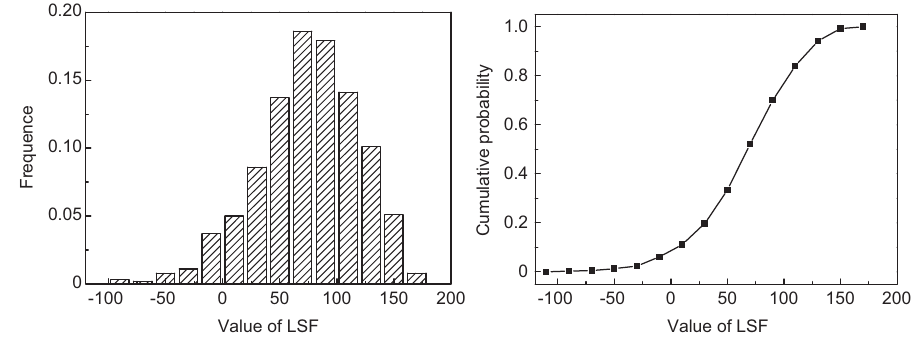
Figure 5 PDFs and cumulative distribution function of LSF.